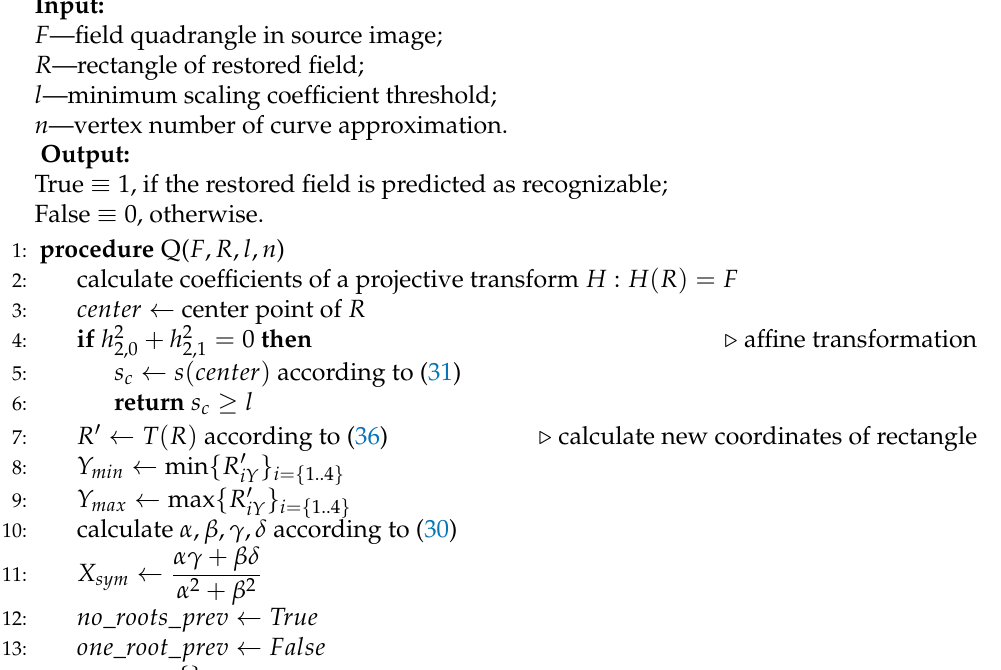
Algorithm 1 For quality assessment of a projectively distorted field